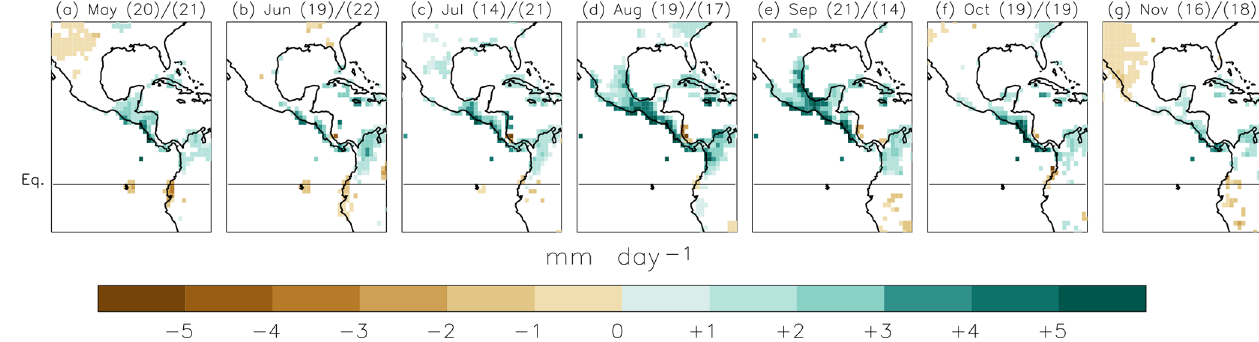
Figure 7. GPCC precipitation differences between months with CHOCO-D over + / − 1 standard deviation for the 1901–2013 period (number of + 1 / − 1 cases are indicated in brackets). Only areas with precipitation differences statistically significant at p < 0 . 05 are represented.